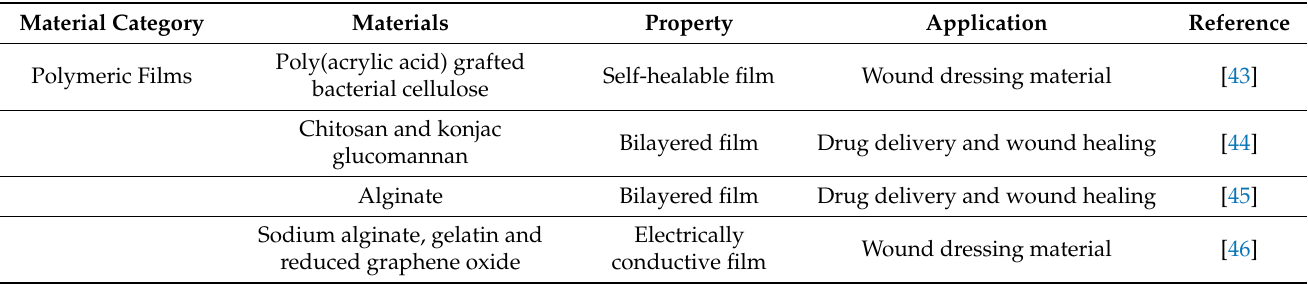
Table 1. Category, property and application of the different polymer-based biomaterials. Material